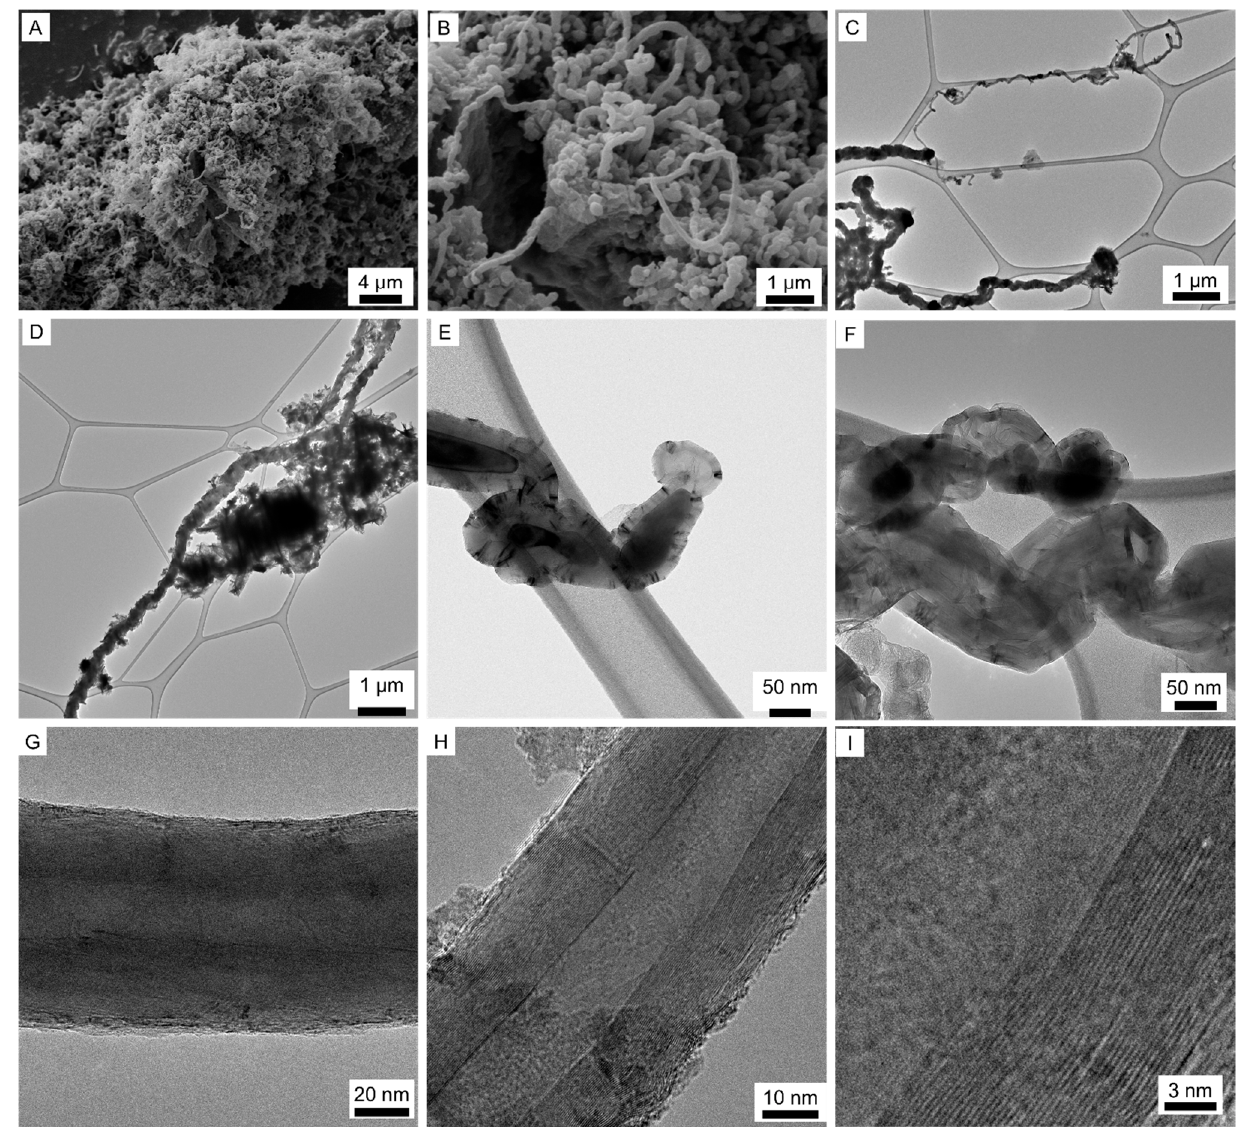
Figure 4. Carbon nanofibers supported in calcium oxide. ( A , B ) SEM images from the as-grown sam- ples showing the growth of the CNF on the surface of calcium oxide particles. ( C – I ) TEM images after the acid washing for the removal of the calcium oxide support.